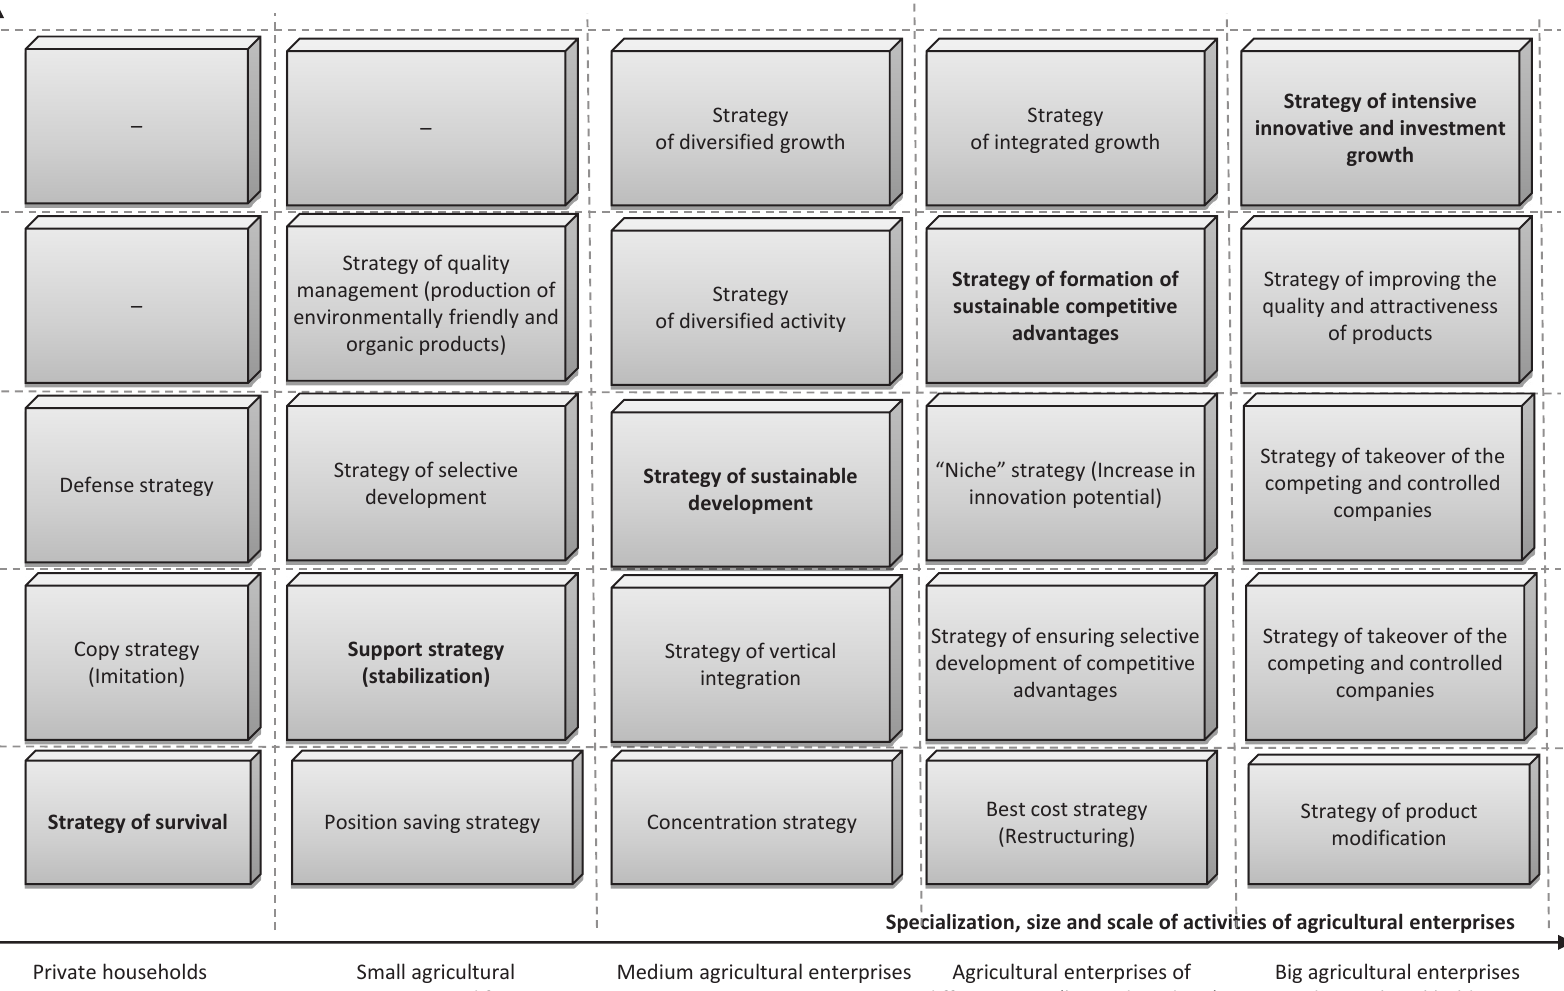
Figure 1. Alternative strategies for innovative activities of agricultural enterprises